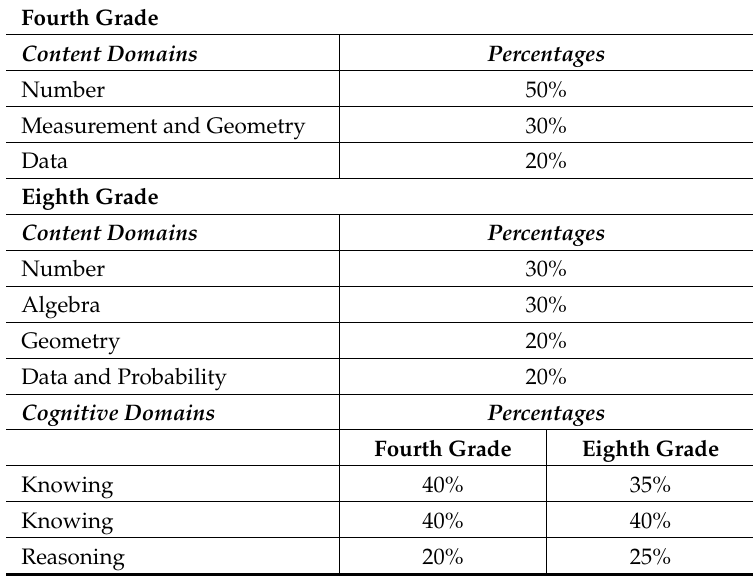
Figure 1. Comparison of Mathematics Skills in Australia–Trends in International Mathematics and Science Study (TIMSS). Table 1. Mathematics Assessment Framework